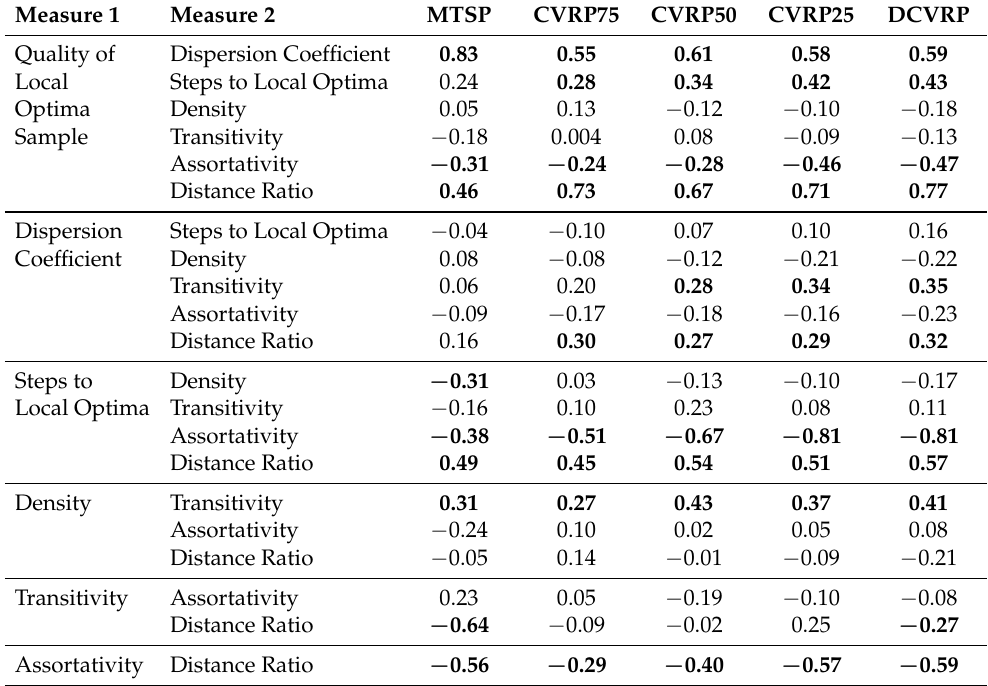
Table 4. Spearman Rank Correlation for LONA measures, comparison for the capacity attribute. Bold values denotes the coefficients that are significant at a α =